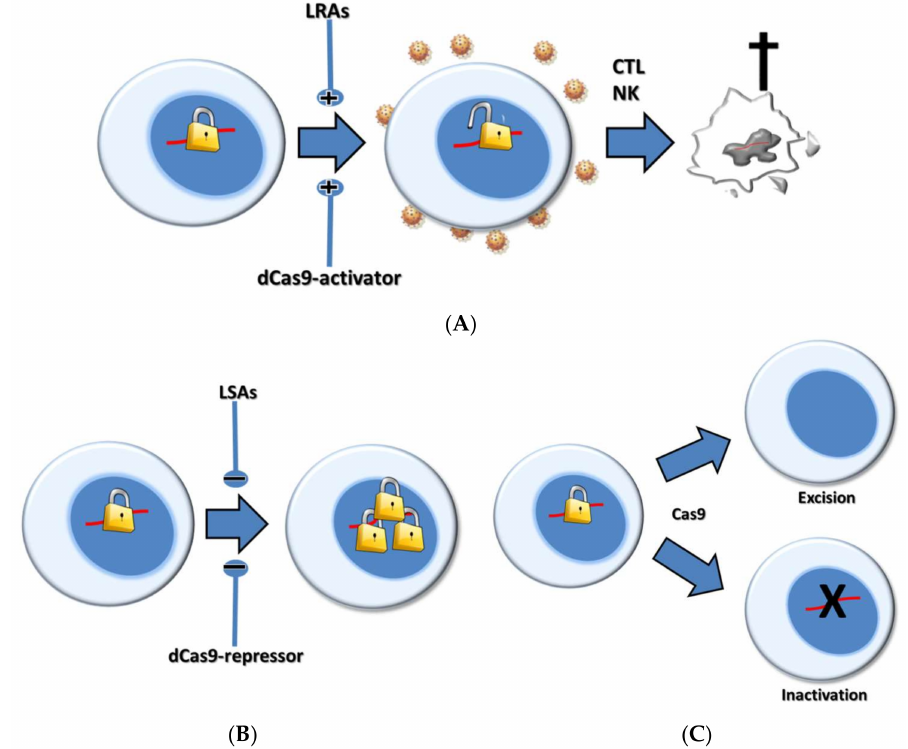
Figure 1. Pharmacological versus clustered regularly interspaced palindromic repeats (CRISPR)-based anti-human immunodeficiency virus (HIV) strategies. ( A ) Latency-reversing agents (LRAs) or dCas9-activators can be used to reverse HIV-1 latency (the “shock”) by activating transcription (+). This step leads to cytotoxic T lymphocytes (CTL)-mediated killing of the virus-producing cells (“the kill”); ( B ) Latency-strengthening agents (LSAs) or dCas9-repressors can be used to reinforce latency by suppressing transcription ( − ). This strategy should prevent viral rebound following treatment interruption; ( C ) CRISPR-Cas9 can be used to inactivate the HIV-1 proviral reservoir by excision or